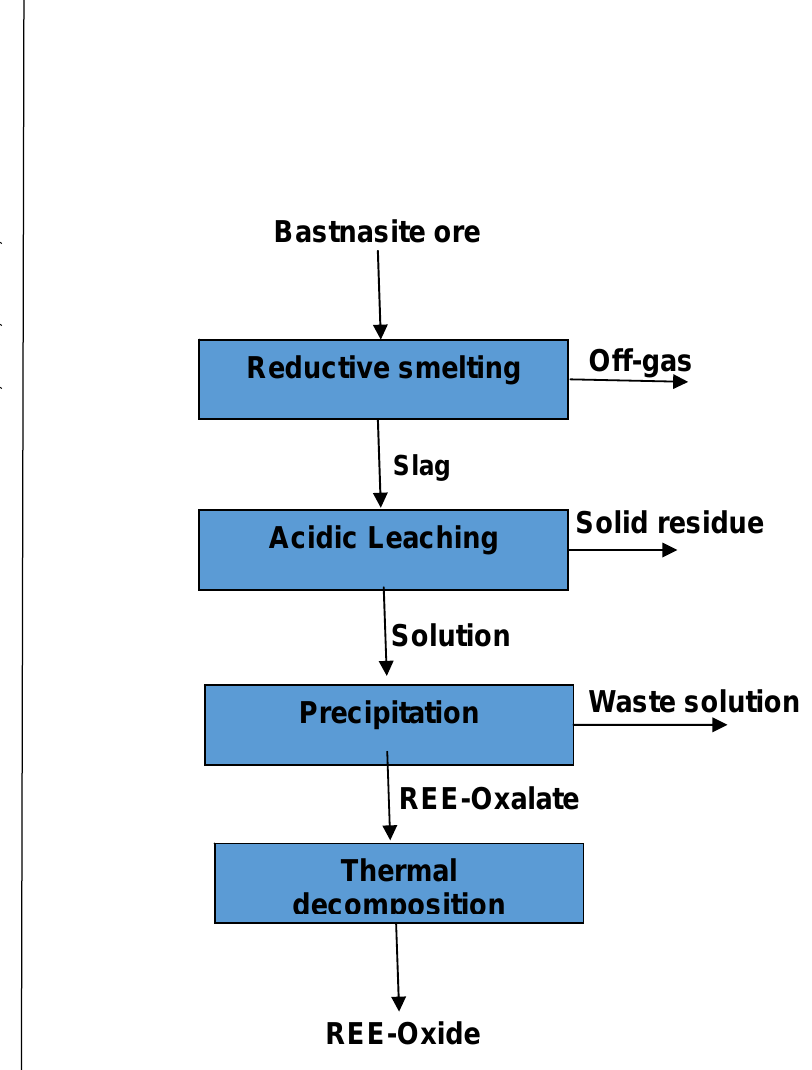
Figure 1 – Research strategy from bastnasite ore to rare earth